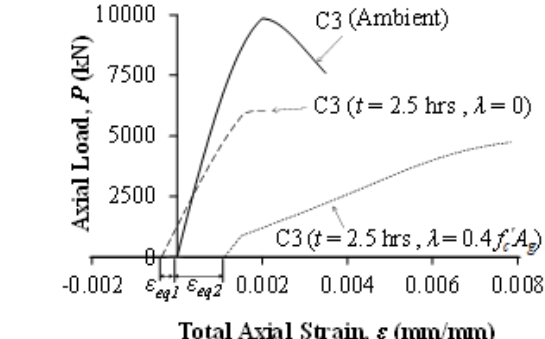
Figure 10. Influence of initial load level on the residual ( P - ε ) relationship.